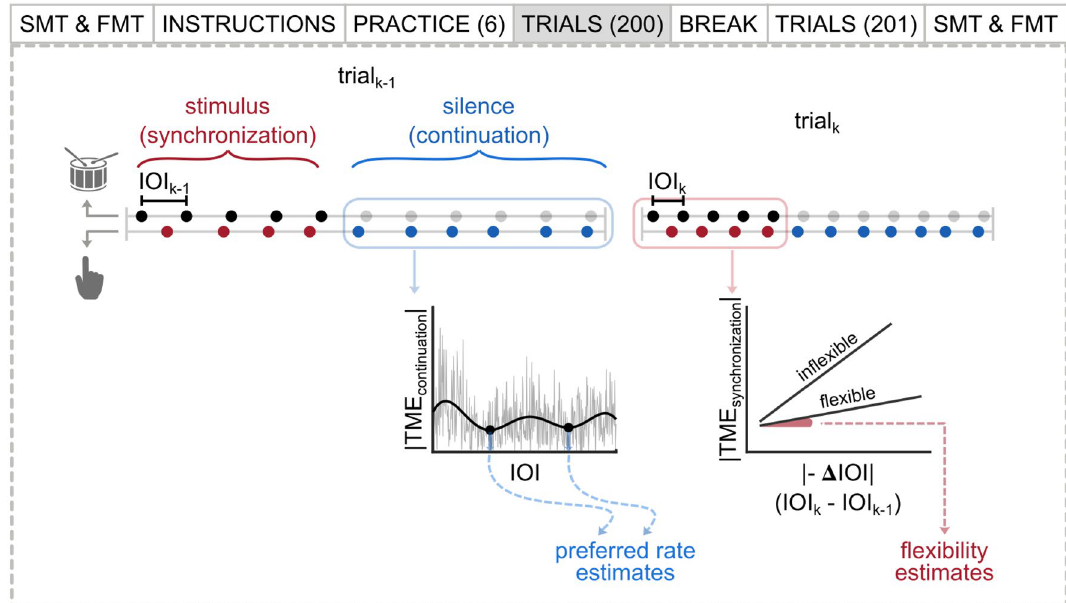
Figure 1. The experiment procedure of a single session, and illustration of the methods used to estimate preferred rate and flexibility. The horizontal lines represent the temporal structure of events in two consecutive trials. Dots on the top line represent the isochronous stimulus; audible sounds in black, and inaudible, theoretical timestamps in transparent gray. Dots on the bottom line represent synchronization (red) and continuation (blue) taps. Tempo-matching errors (TME) were calculated as the difference between stimulus IOI and tapping rate, separately from synchronization and continuation sections of the trials. Individuals’ preferred rates were estimated by fitting curves to their |TME continuation | values over the IOI range and obtaining their local minima. Flexibility was estimated by fitting linear models to individuals’ single-session data where |TME synchronization | was predicted by |− ΔIOI|, and obtaining slopes, with a smaller value indicating more